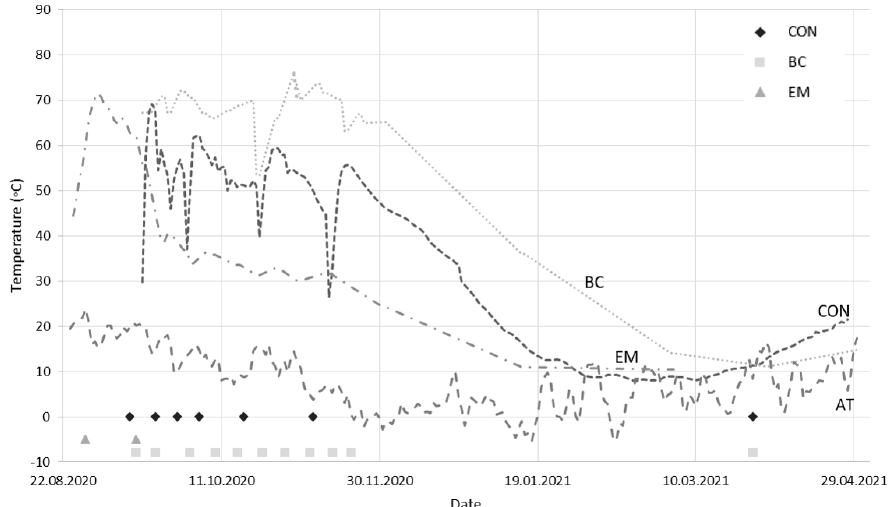
Figure 2. Temperature dynamics during composting are represented by the lines (CON, BC, and EM), the shapes at the bottom of the graph represent compost turning dates. Bottom line represents ambient temperature (AT).